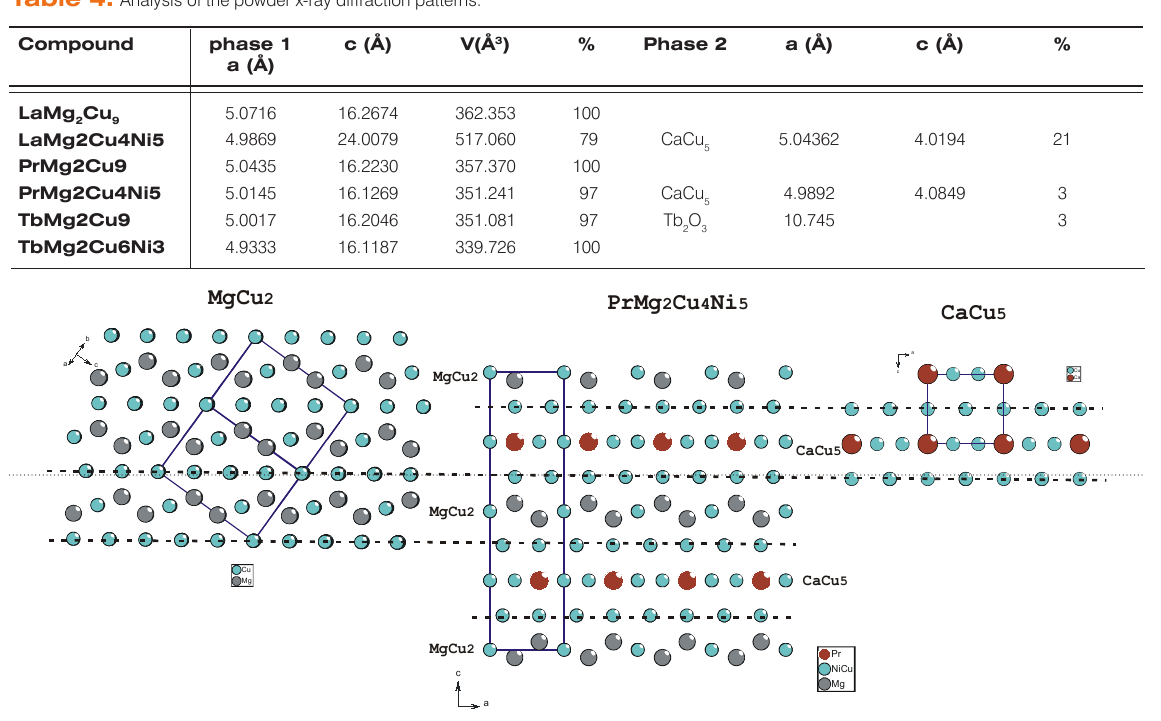
Figure 3. Interstructural relations between the PrMg